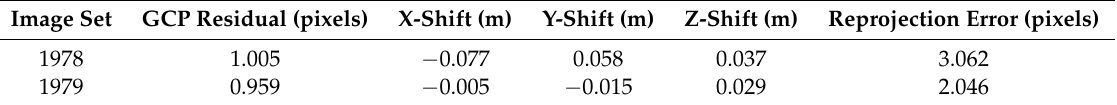
Table 2. Bundle adjustment shifts after eight iterations. The values for GCP residuals are an average for the entire dataset. Image